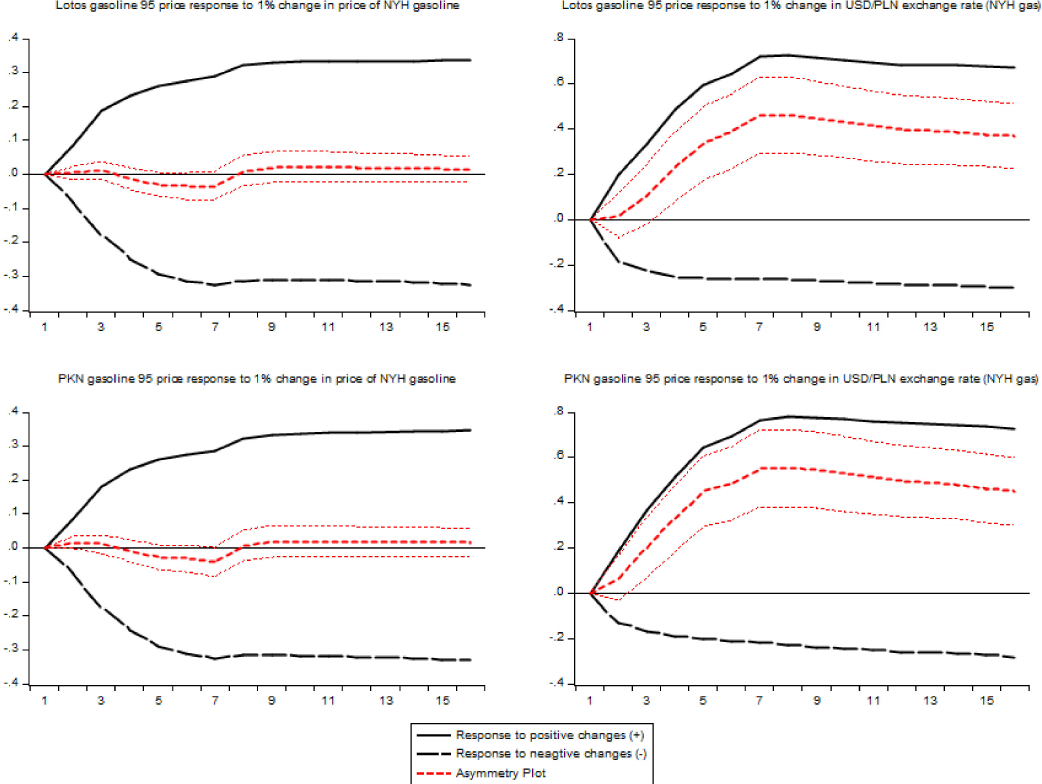
Figure 6. Dynamic multipliers—whole sample, wholesale Gasoline 95, and